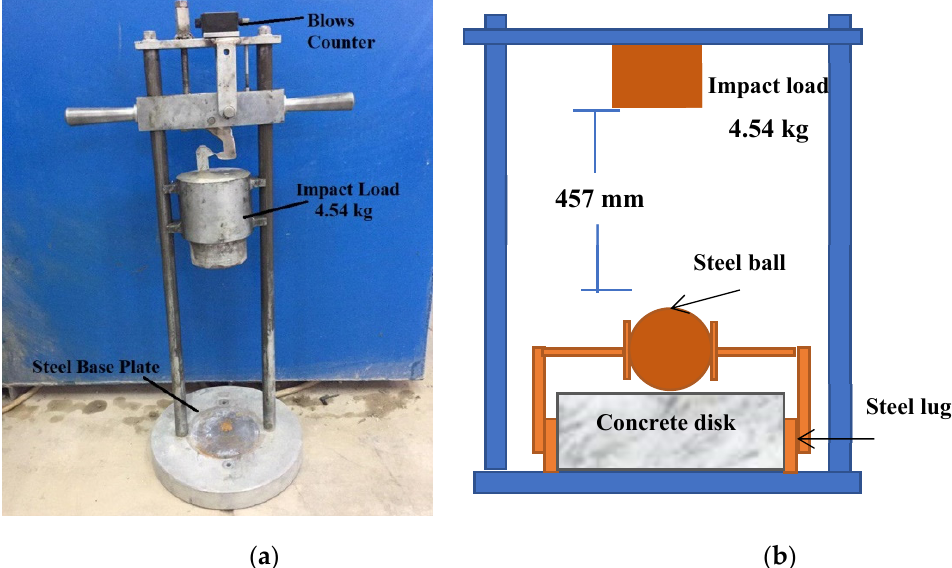
Figure 2. ACI 544-2R repeated impact testing apparatus. ( a ) ACI 544-2R apparatus. ( b ) Detailed sketch.